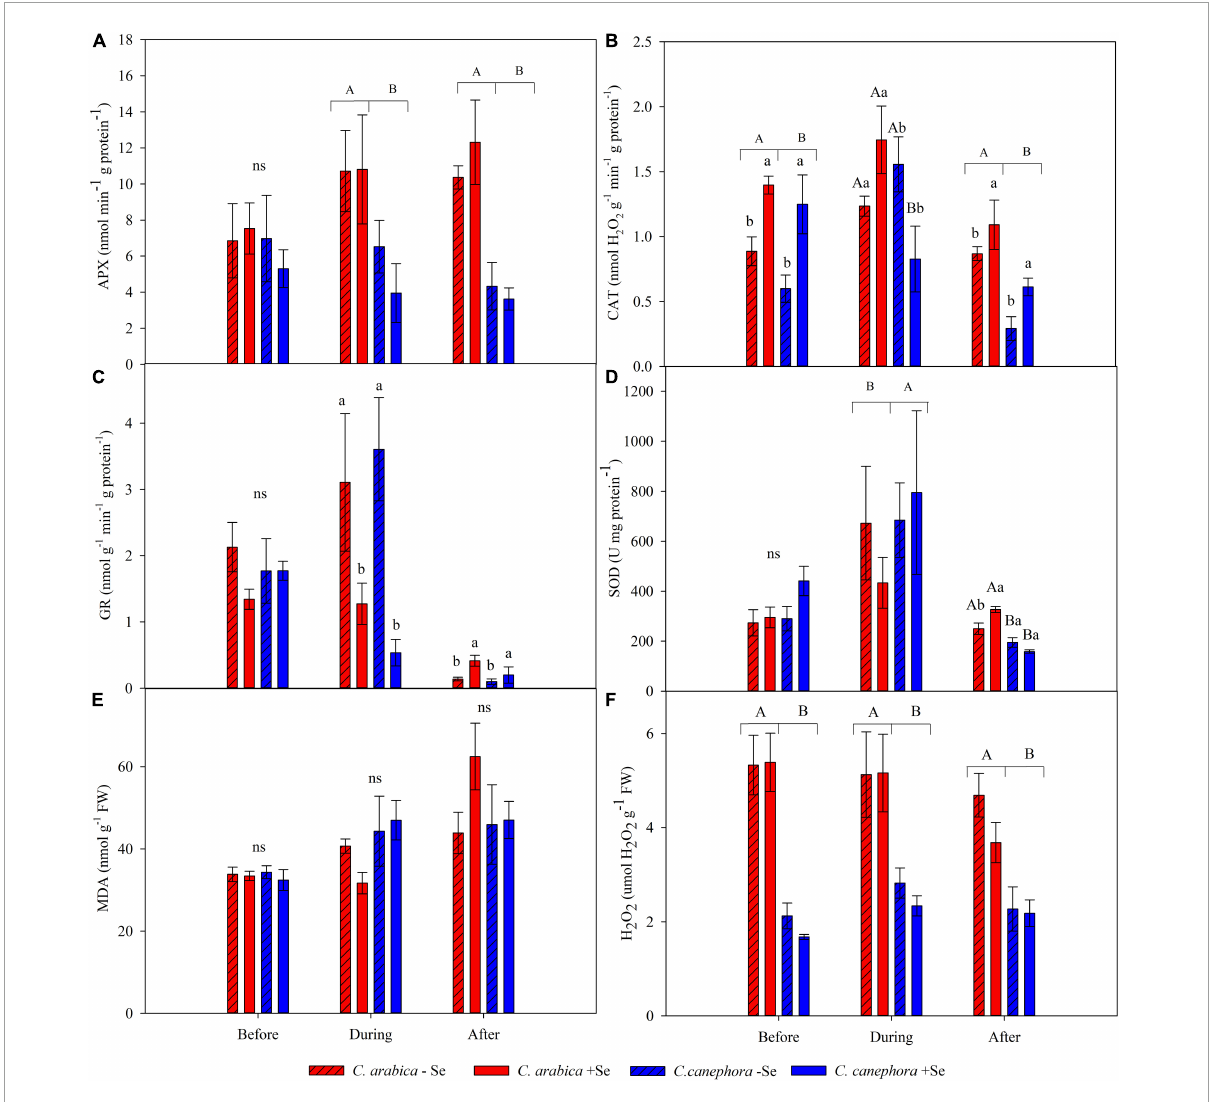
FIGURE3 Effects of Se foliar application on APX (A) , CAT (B) , GR (C) , SOD (D) , MDA (E) , and H 2 O 2 (F) in leaves of C. arabica and C. canephora during the rewarming. Mean values followed by different lowercase letters within Se supply conditions (with selenium and without Se) in each genotype are significantly different ( p < 0.05, n = 5) by Tukey multiple comparison tests as well as different uppercase letters that indicate significant differences in species ( C. arabica and C. canephora ). Vertical bars represent the standard